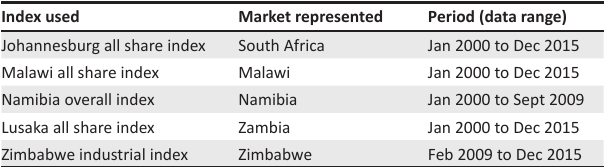
TABLE 1: Indices used and data range. Index used Market